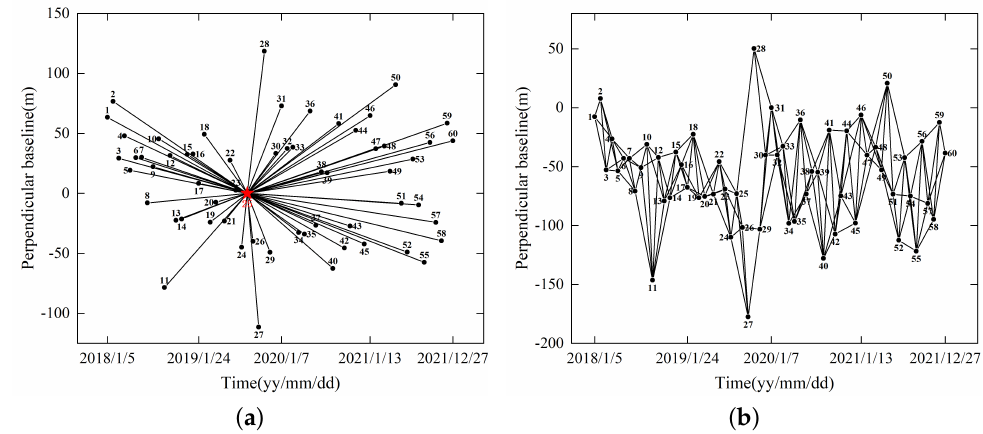
Figure 4. ( a ) Time − Position map of PS-InSAR. ( b ) Time − Position map of SBAS-InSAR. The master image is presented as a red star, the slave images are presented as black dots, and all images are marked with the serial number in Table 1. Each line represents a master-slave image pair, and the horizontal and vertical coordinates show their time and space